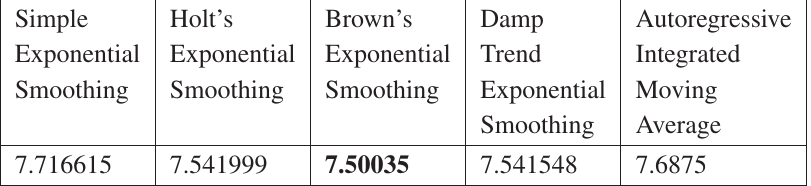
Table 3. MAPE comparison results for products in a group